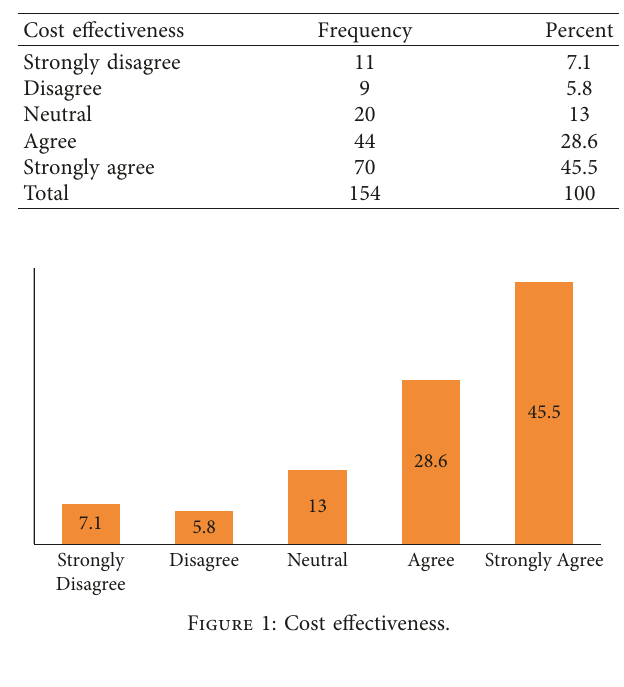
Table 1: Cost effectiveness.